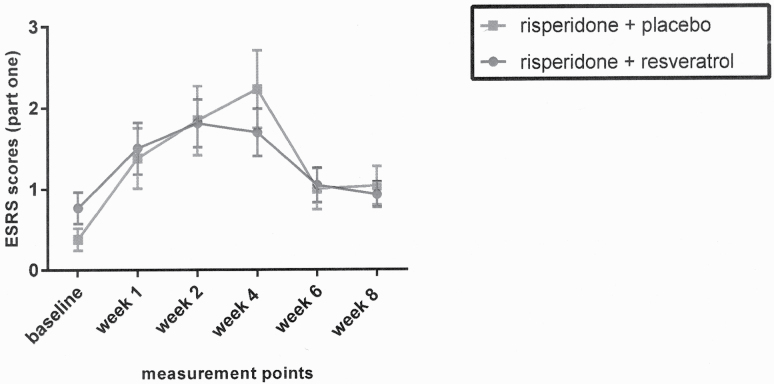
Repeated-measure ANOVA for comparison of effects of 2 treatments on the ESRS score. Values represent mean ±  SEM.